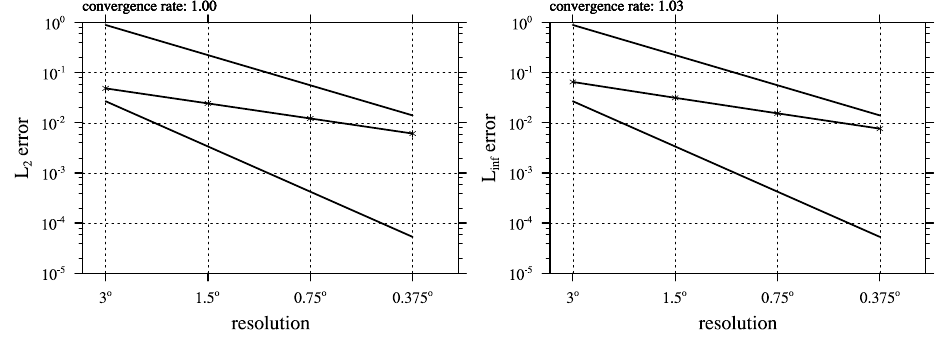
Figure 8. Test of convergence for the deformation test case with Gaussian initial condition using error norms l 2 (left) and l ∞ (right). The Courant number is fixed. The upper reference line is for second order, and the lower one is for third order.